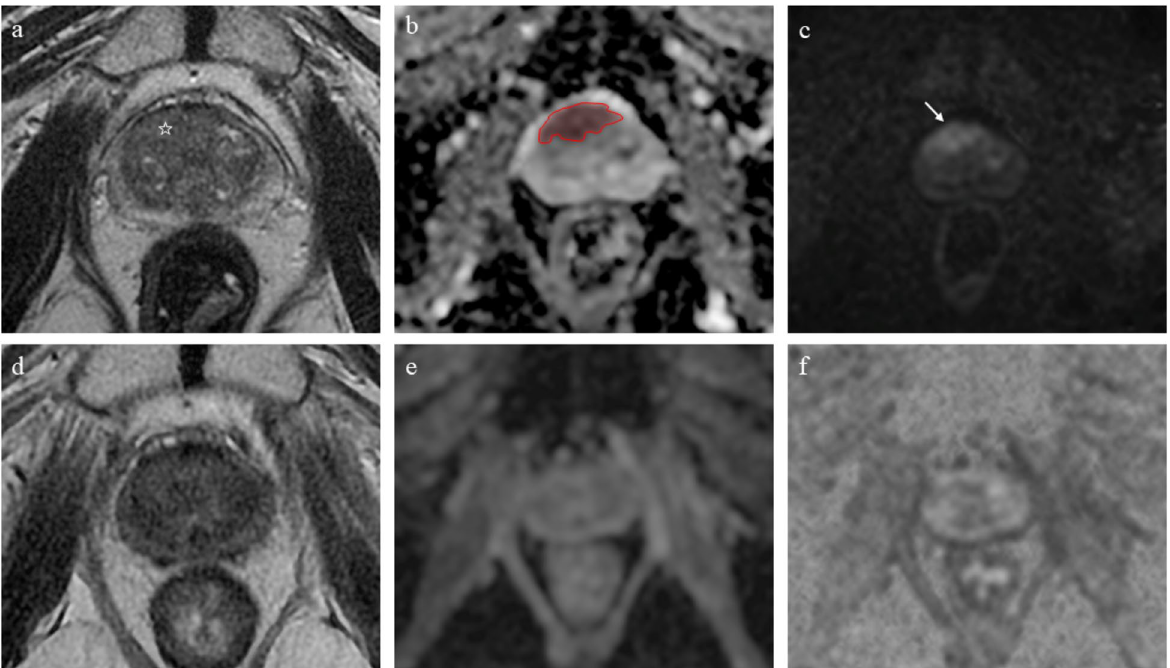
Fig. 2 Sixty-nine-years old patient treated with external beam radiotherapy after MRI targeted biopsy revealed 3 4 Gleason score prostate cancer. + Images from pre-biopsy ( a c ) as well as post-treatment ( d f ) MRI scans are presented. The index lesion (PI-RADS 5) can be appreciated on the − − T2-weighted images ( a , lesion epicentre marked with a white star) as a homogeneous, moderately hypointense area with obscured margins in the right anterior transition zone. Corresponding marked and focal hypointensity on ADC map ( b , red region of interest) and hyperintensity on high b value DWI ( c , white arrow) are present. On the corresponding post-treatment sequences ( d f ), no abnormalities can be detected, suggesting − a good treatment response. DWI Diffusion-weighted imaging, MRI Magnetic resonance imaging, PI-RADS Prostate Imaging-Reporting and Data